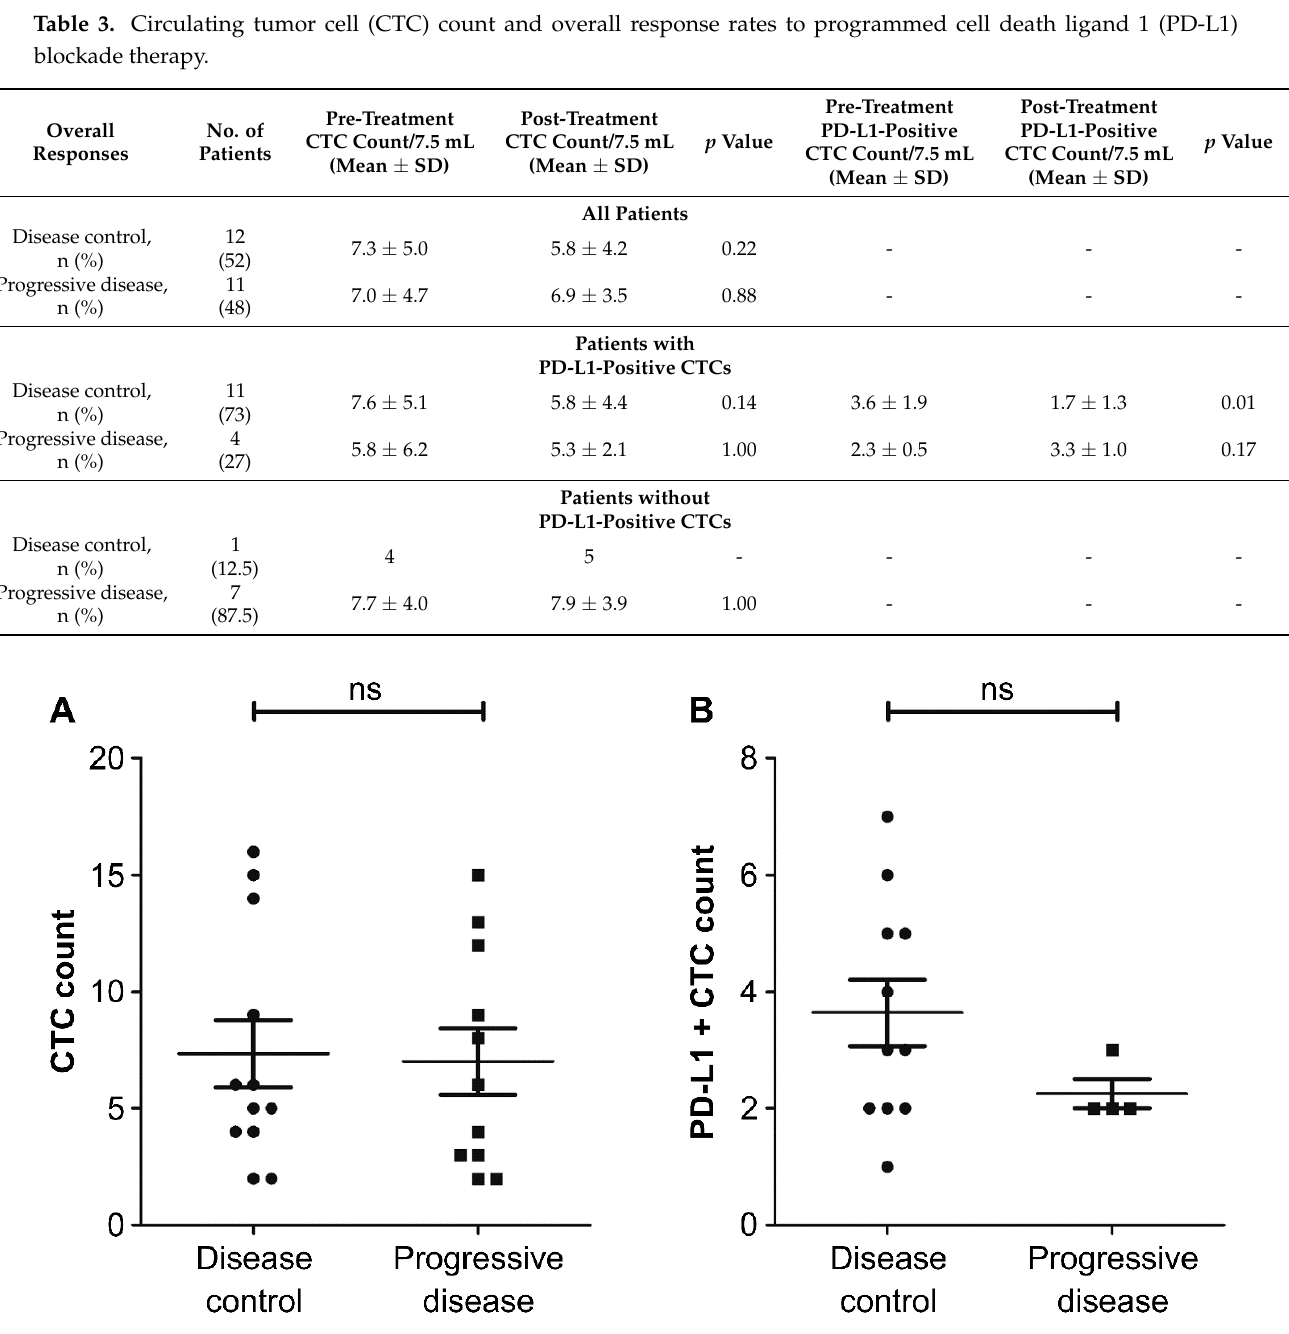
Figure 3. ( A ) Baseline circulating tumor cell (CTC) count of patients with urothelial carcinoma (UC) in the disease control group and the progressive disease group ( p = 0.78). ( B ) Baseline programmed cell death ligand 1 (PD-L1)-positive CTC count of patients with UC in the disease control group and the progressive disease group ( p = 0.22). ns: not significant. Table 3. Circulating tumor cell (CTC) count and overall response rates to programmed cell death ligand 1 (PD-L1) block- ade therapy .